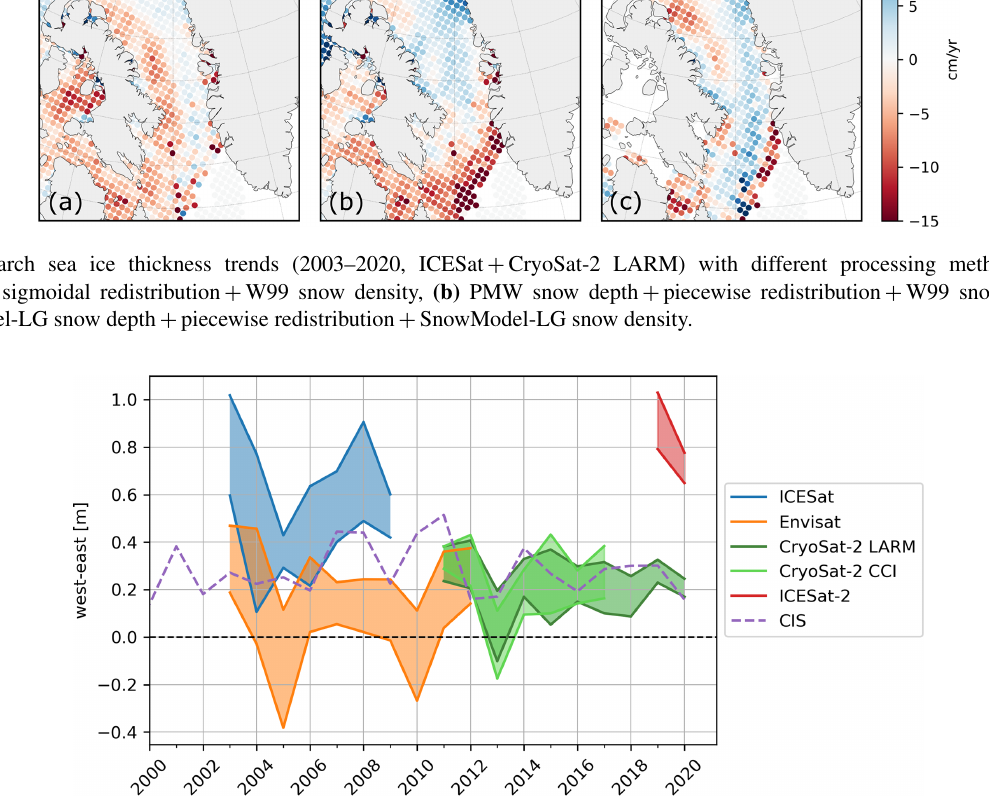
Figure 8. Time series of west–east sea ice thickness asymmetry from the different satellite altimeters and the estimated sea ice thickness from CIS ice charts. The envelopes show the range of outcomes from different processing